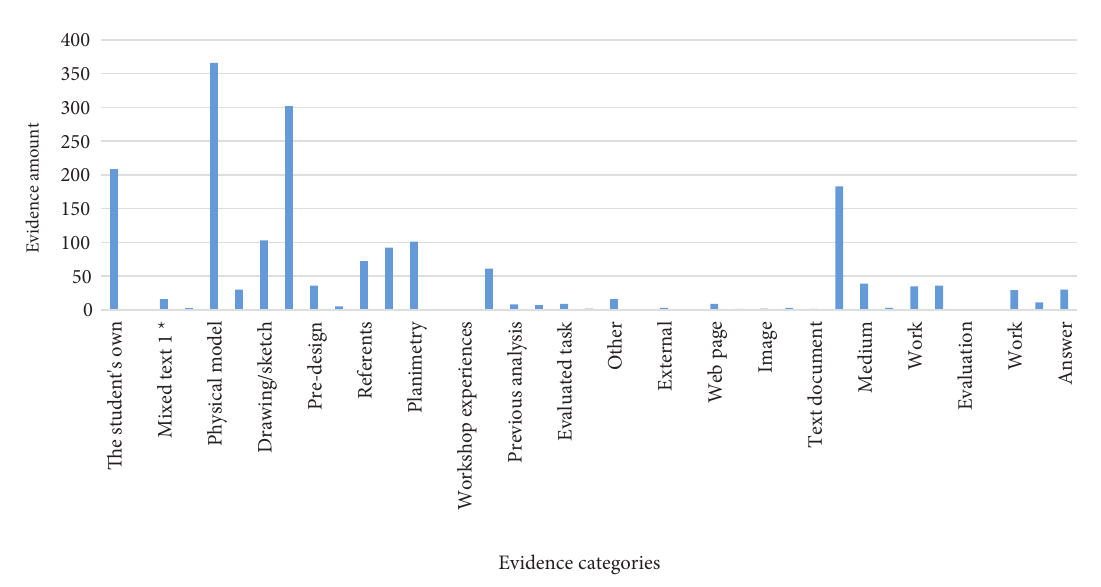
Figure 3. Distribution of the average of evidence for the different specific aspects present in the e-portfolios (source: Authors, 2019)